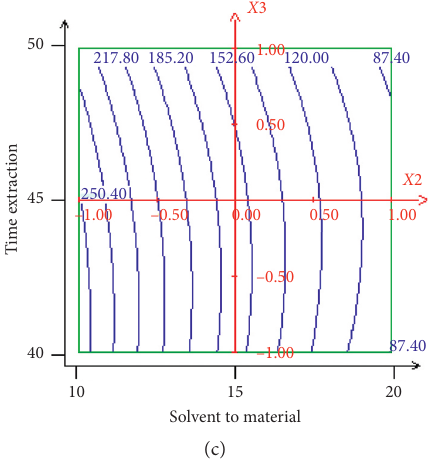
Figure 5: Contour plots for the effect of independent variables on polyphenol content in hydroethanolic extract. (a) Contour plot graph showing interaction between solvent-to-material ratio ( X 2) and ethanol concentration ( X 1); (b) contour plot graph showing interaction extraction time ( X 3) and solvent-to-material ratio ( X 2); (c) contour plot graph showing interaction between extraction time ( X 3) and ethanol concentration ( X